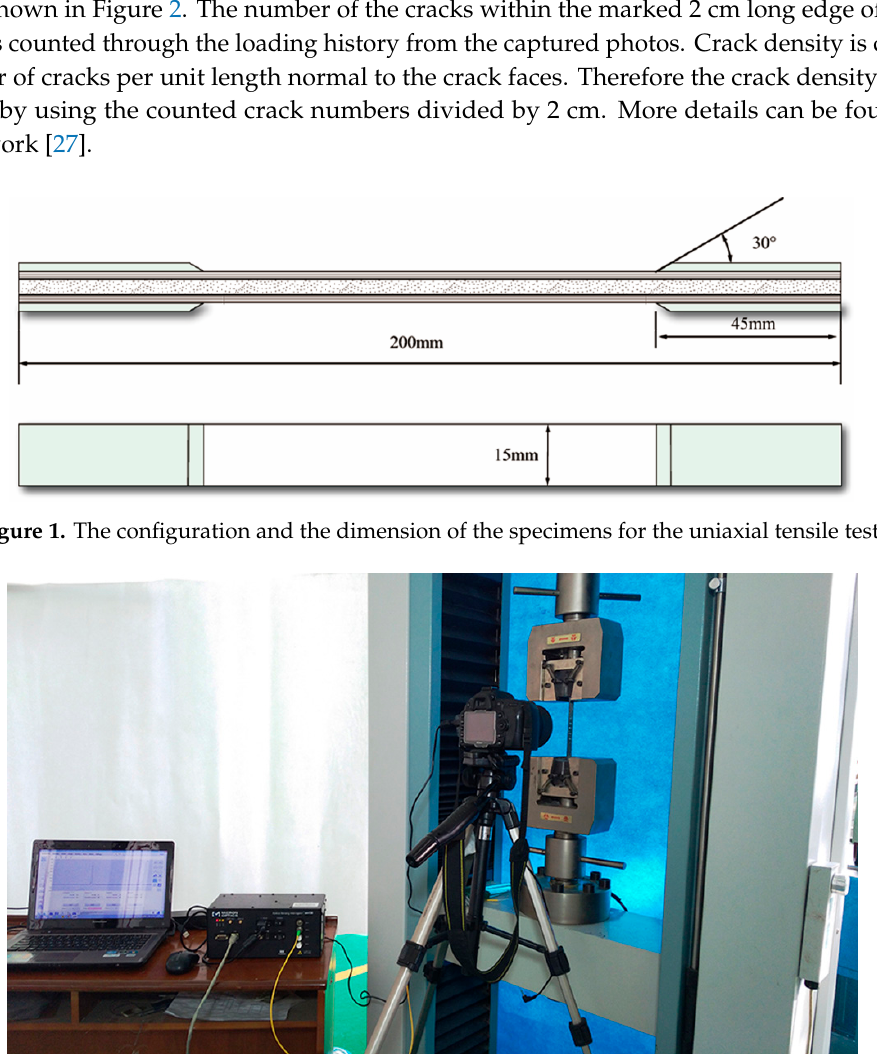
Figure 2. Photograph of the testing system for the transverse crack test.